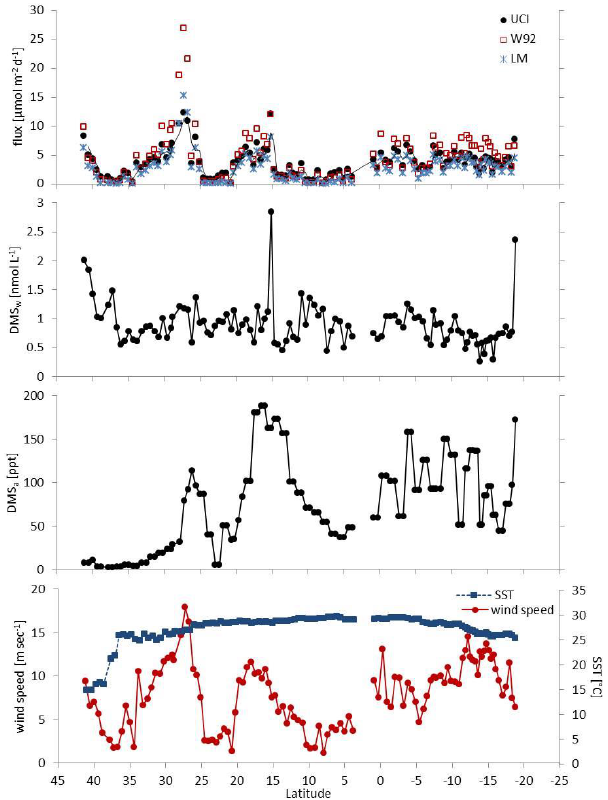
Fig. 2. Shipboard measurements and subsequent flux calculations over the TransBrom cruise track (by latitude, positive denotes north- ern latitudes and negative southern), from top: panel 1 computed DMS fluxes using the UCI k parameterisation (UCI – solid cir- cle), the Wanninkhof (1992) parameterisation (W92 – open square), and the Liss and Merlivat (1986) parameterisation (LM – asterix); panel 2 measured seawater DMS concentrations from Zindler et al. (2013); panel 3 measured atmospheric DMS mixing ratios; panel 4 measured horizontal wind speed (solid circle) and sea sur- face temperature (solid